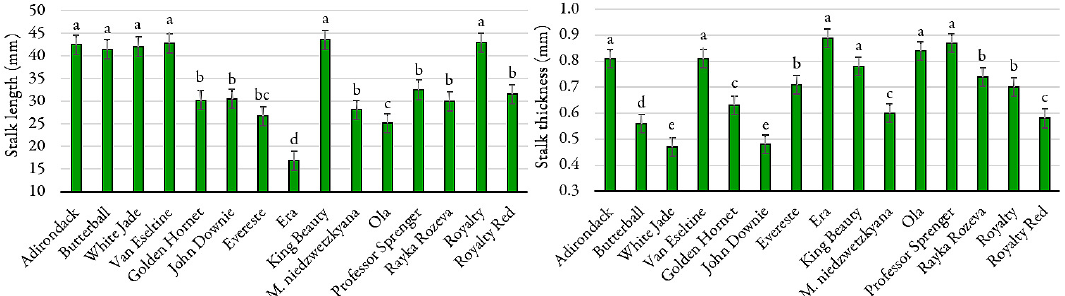
Figure 3. The main stalk characteristics of the 15 cultivars of ornamental crabapples analyzed